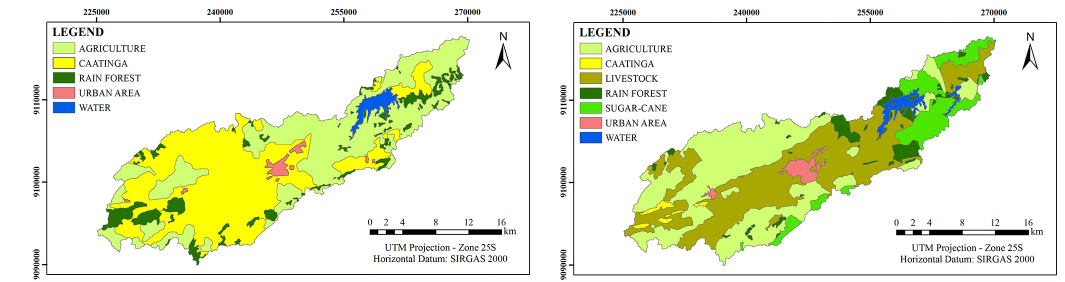
Figure 4. Land use and land cover maps of the Tapacurá River basin for: (a) 1967–1974, and (b)